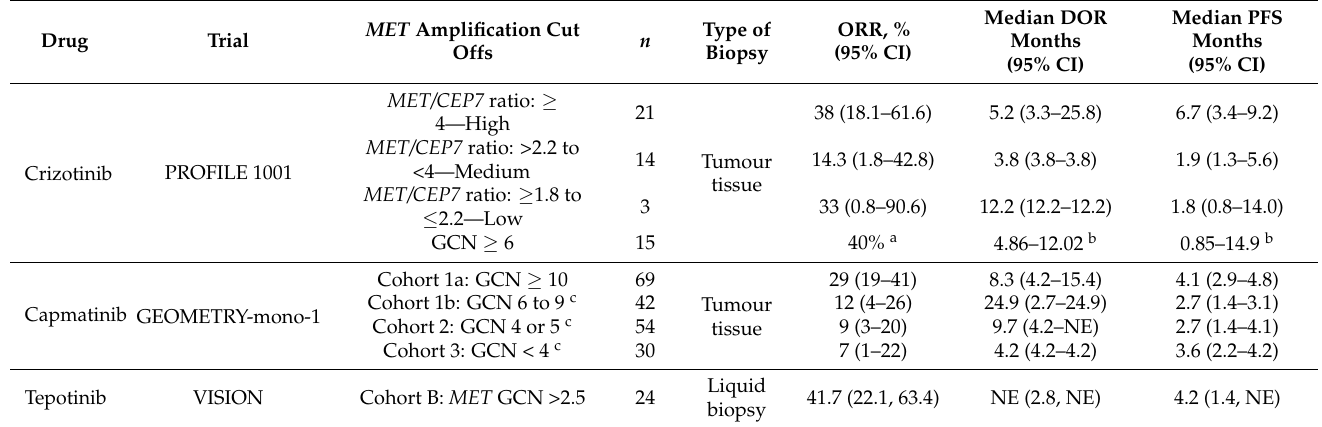
Table 3. Trials with MET inhibitors in NSCLC with MET